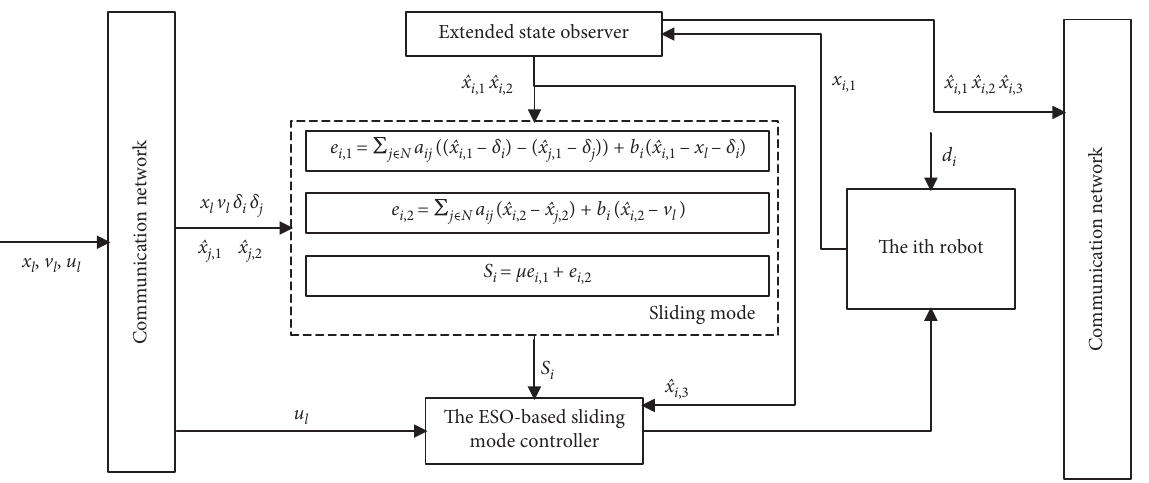
Figure 1: The proposed control block